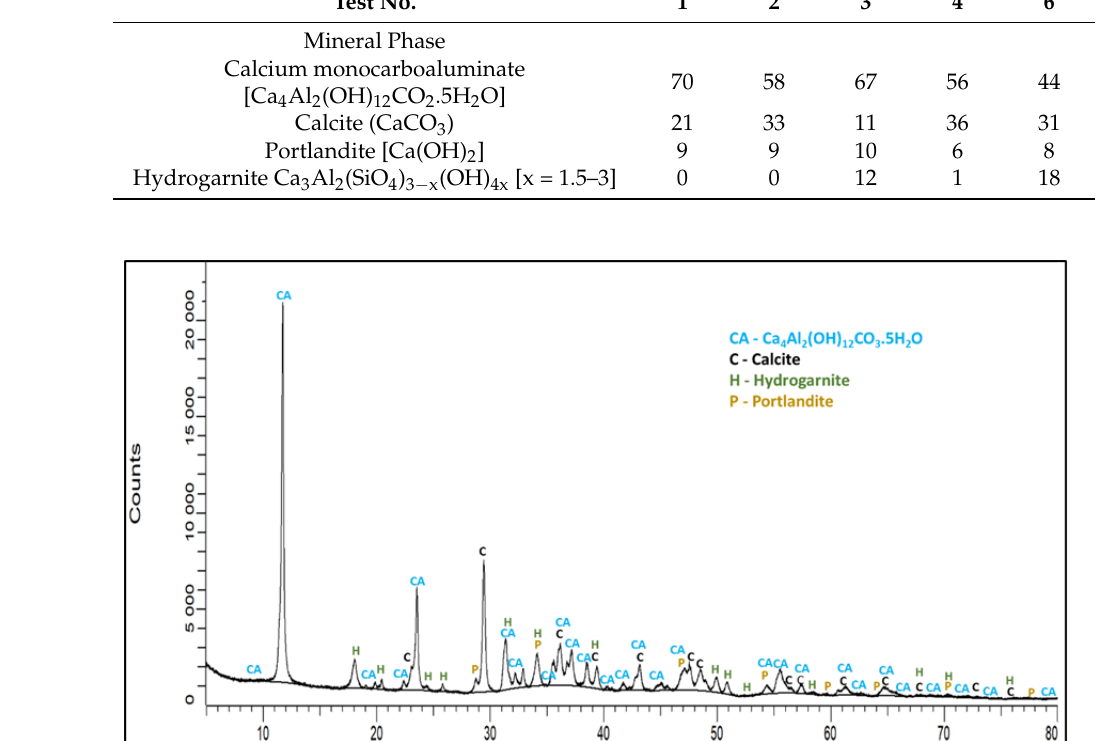
Table 9. XRD semi-quantitative analysis of phases in the desilication filter cake (wt%). Test No.